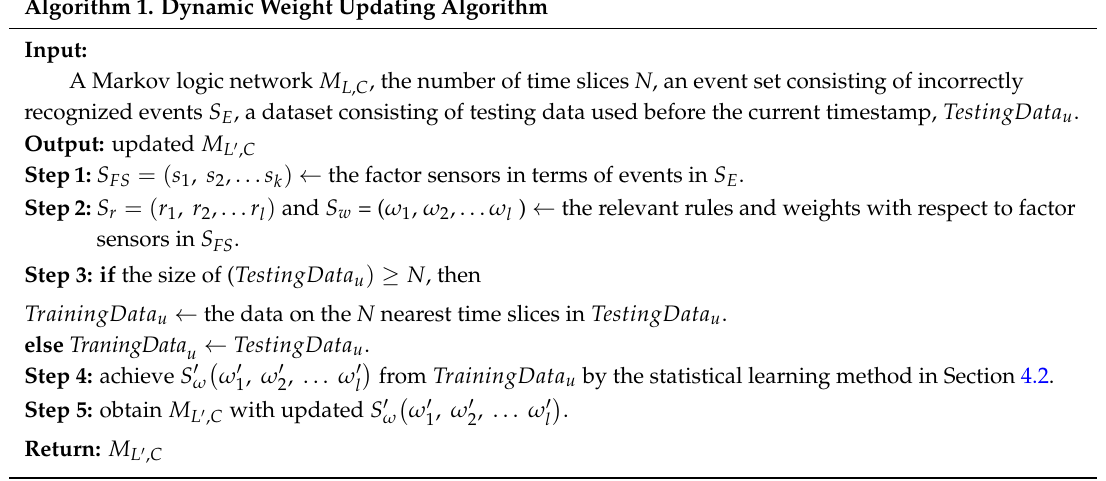
Algorithm 1. Dynamic Weight Updating